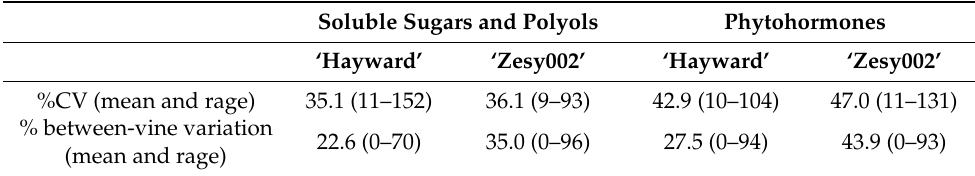
Table 5. Mean (and range) %CV and mean %CV due to between-vine variation for soluble sugars and polyols measured, leaf and fruit of ‘Hayward’ and ‘Zesy002’ kiwifruit at three harvest times, and for nine gibberellins, cytokinins and stress phytohormones where these co-occur in selected plant